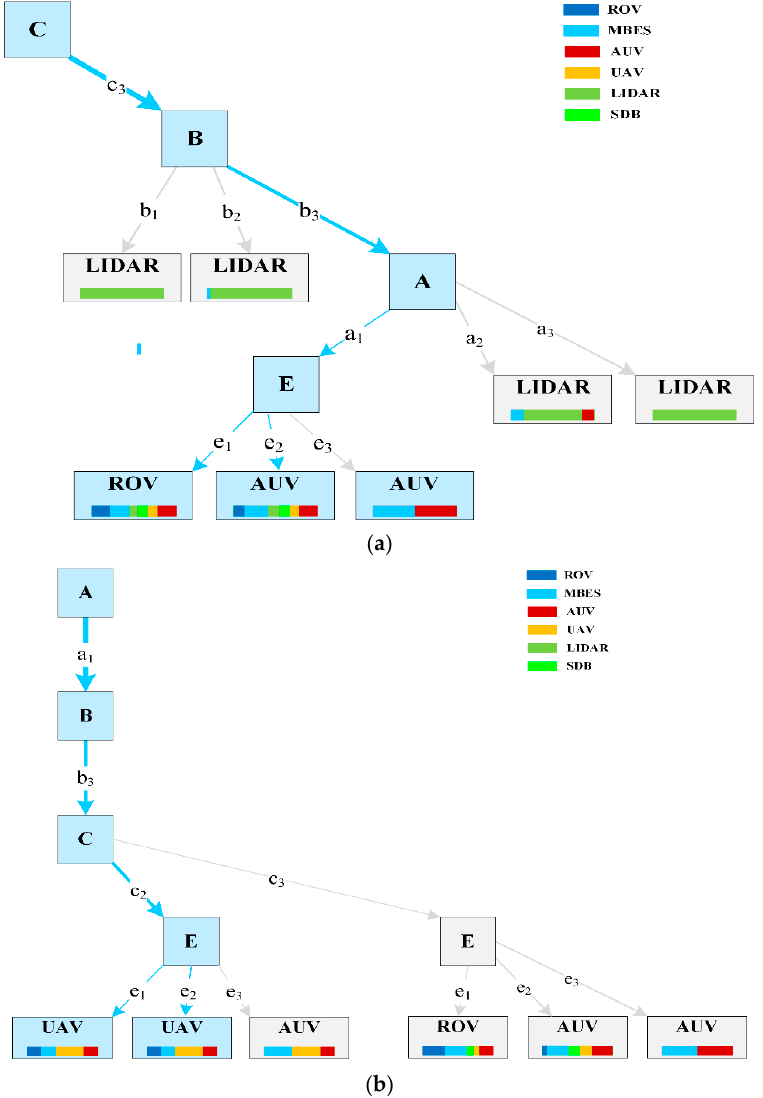
Figure 6. A tree decision model for Kaštela Bay study case: ( a ) using information gain ratio algorithm; ( b ) using Gini algorithm.